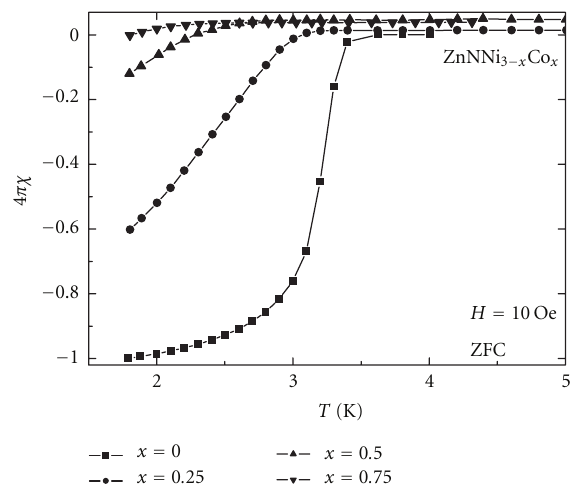
Figure 2: Temperature dependence of magnetic susceptibility, χ , normalized by 1 / 4 π for ZnNNi 3 − x Co x under 10Oe between 1.8K and 5 K obtained by the ZFC